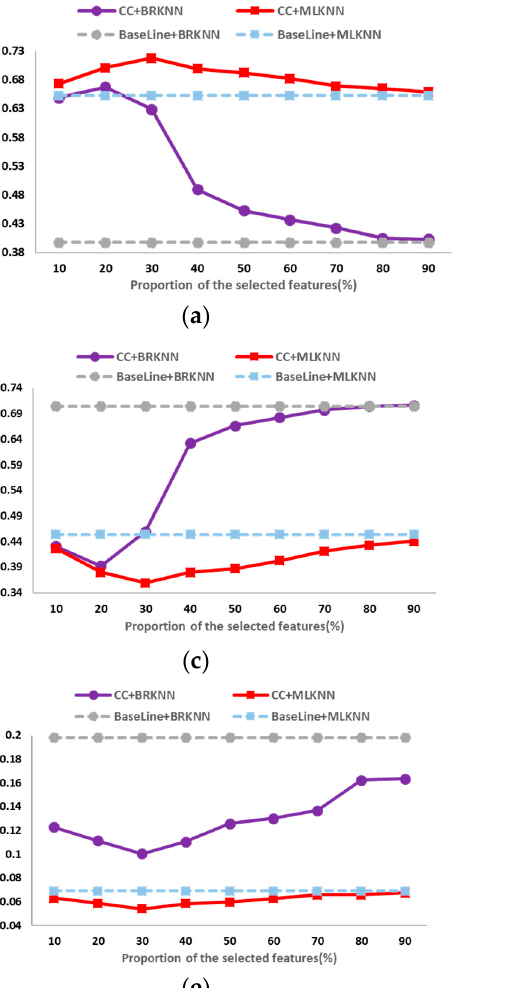
Figure 6. Experimental results on Health data set. ( a ) Average Precision; ( b ) Hamming Loss; ( c ) One Error; ( d ) Coverage; ( e ) Ranking Loss.